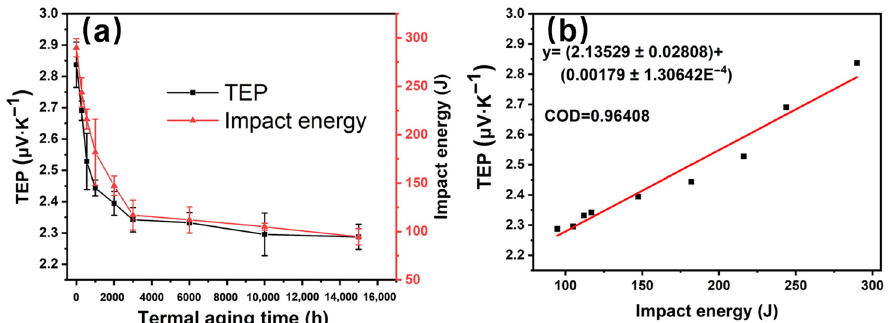
Figure 8. TEP and impact energy with respect to thermal aging time for Z3CN20-09M stainless steel ( a ), and the linear relationship between TEP and impact energy ( b ).